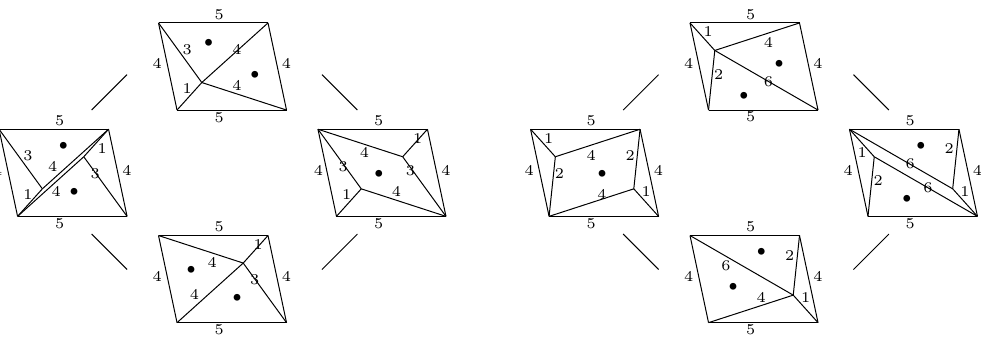
Figure 8 . Two networks which contribute to a 4 th-order pole in the e (1)